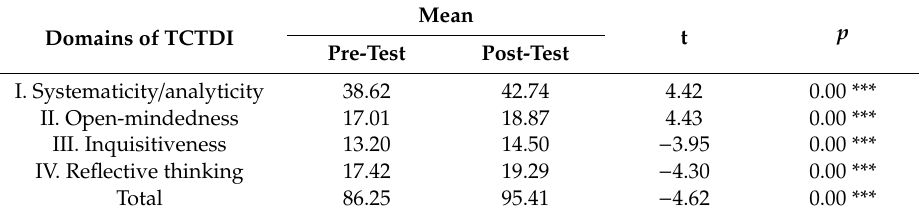
Table 2. Comparison of scores of TCTDI before and after ELP ( n = 103).